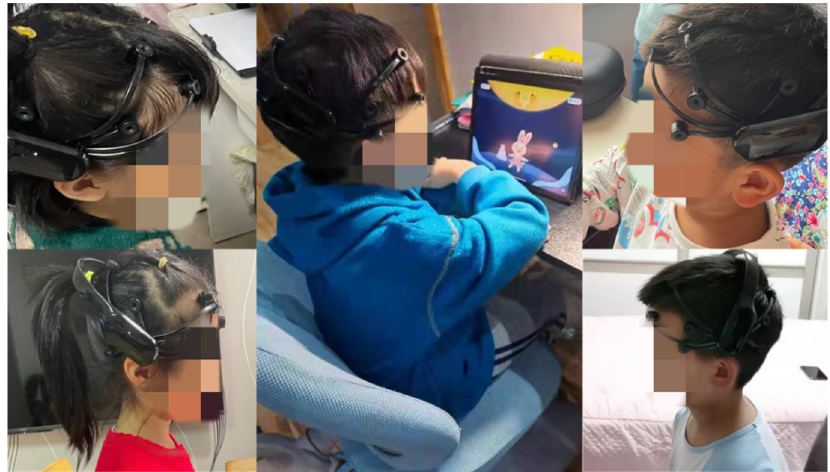
Figure 16. The game training process of the experimental group.